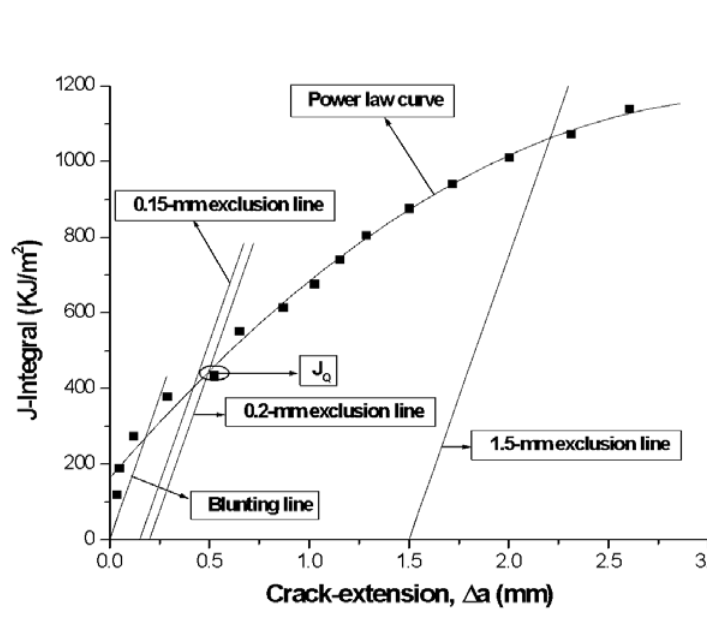
Figure 5: Determination of J Q Using J-Integral versus Δ a